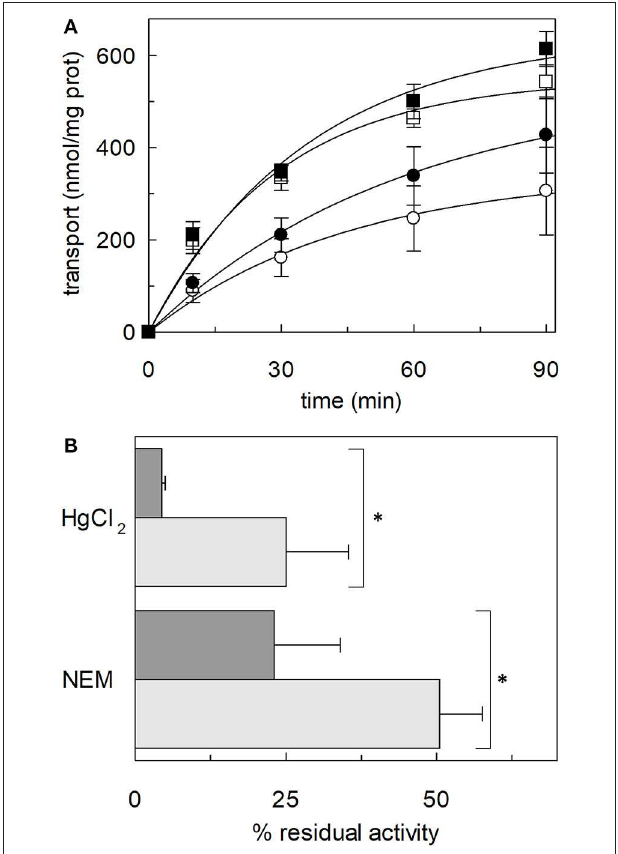
FIGURE 8 | Effect of SH reagents on the transport activity of hASCT2 reconstituted in proteoliposomes. (A) Effect of DTE. Purified hASCT2 was reconstituted in proteoliposomes prepared without CHEMS ( ◦ , •) or with 75 µ g/mg phospholipids CHEMS ( (cid:3) , (cid:4) ) as described in Materials and Methods. Transport was started by adding 50 µ M [ 3 H]glutamine and 50mM Na-Gluconate in the absence ( ◦ , (cid:3) ) or the presence ( • , (cid:4) ) of 10mM DTE, to proteoliposomes containing 10mM glutamine. Transport was stopped as described in Materials and Methods at the indicated time points. Values were plotted according to the first-order rate equation. (B) Effect of HgCl 2 and NEM. Purified hASCT2 was reconstituted in proteoliposomes prepared without CHEMS (dark gray bars) or with 75 µ g/mg phospholipids CHEMS (light gray bars) as described in Materials and Methods. Transport was started by adding 50 µ M [ 3 H]glutamine and 50mM Na-Gluconate, in the presence of 20 µ M HgCl 2 or 0.5mM NEM, to proteoliposomes containing 10mM glutamine. Transport was measured in 20min. Transport activity was calculated as the percent of residual activity with respect to the control condition (without any addition in the transport assay). *Significantly different from the control sample (proteoliposomes prepared without CHEMS) as estimated by Student’s t -test ( P < 0.05). In (A,B) data are means ± SD of three independent